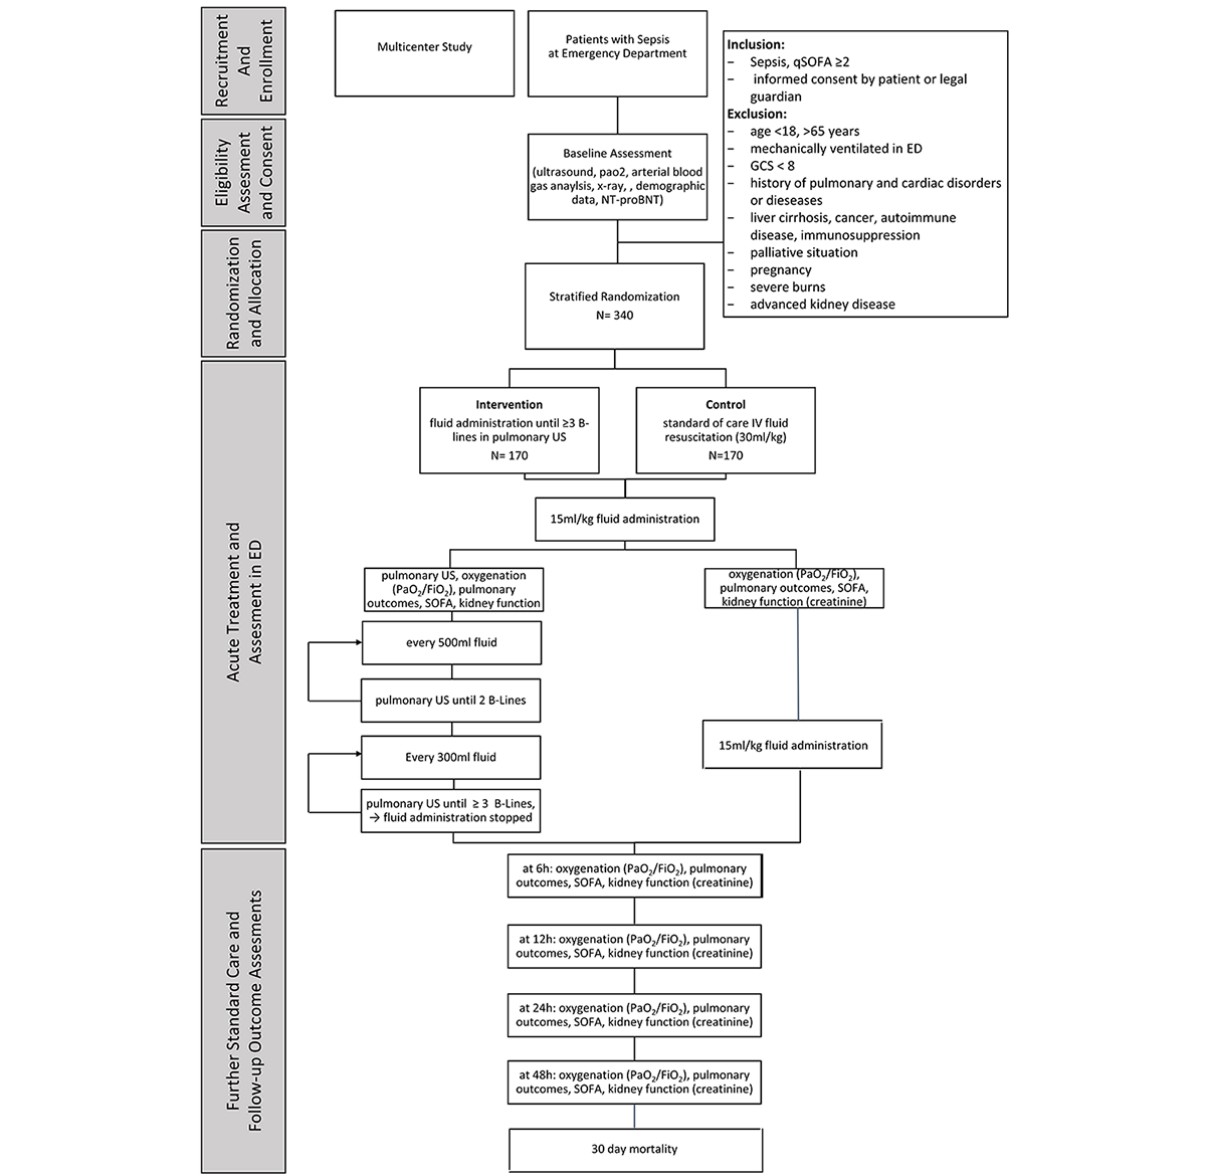
Figure 1. SPIRIT- and CONSORT-compliant flow diagram of study design. ED: emergency department; FiO2: fraction of inspired oxygen; GCS: Glasgow Coma Scale; IV: intravenous; PaO2: partial pressure of arterial oxygen; qSOFA: quick Sequential Organ Failure Assessment; SOFA: Sequential Organ Failure Assessment; US: